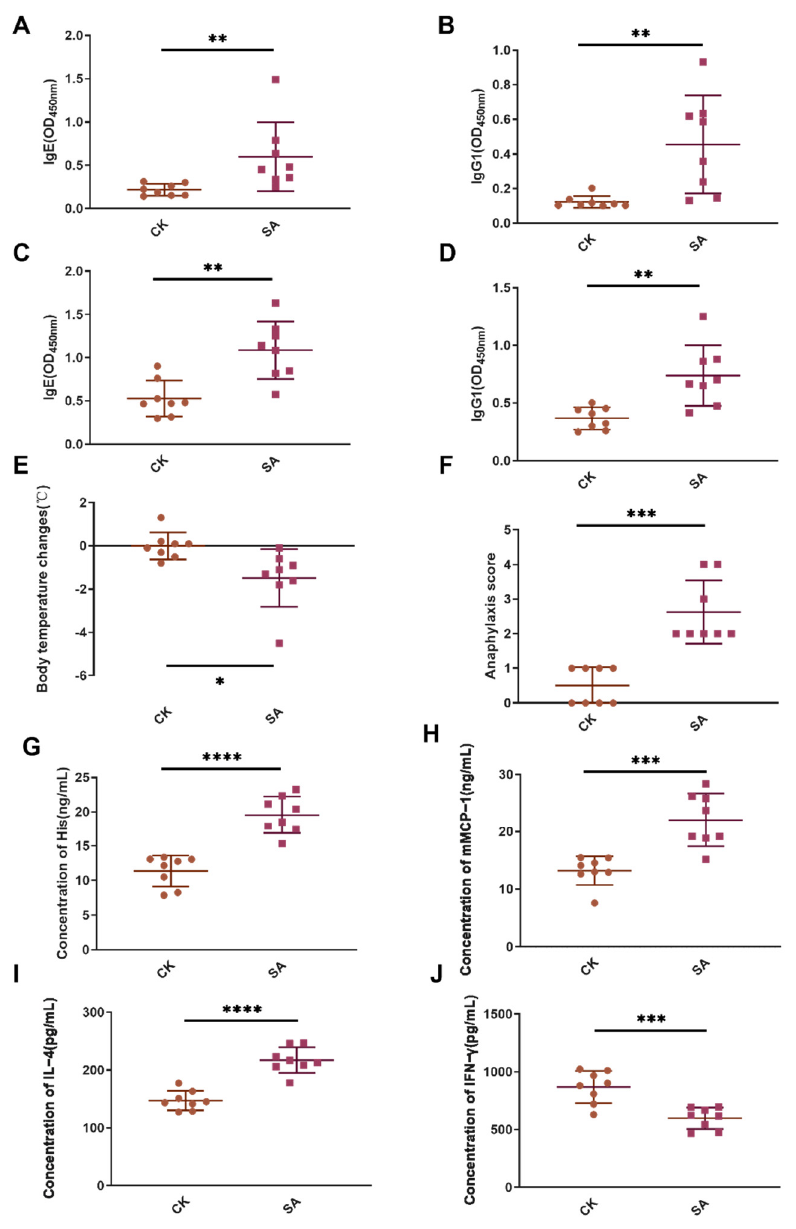
Figure 1. Allergy index analysis of mice in CK and SA groups. ( A , B ) sIgE and sIgG1 levels on day 35; ( C , D ), sIgE and sIgG1 levels on day 42; ( E , F ), body temperature changes and anaphylaxis score after challenge. ( G – J ), histamine, mMCP-1, IL-4, and IFN- γ levels in each group. *, p < 0.05; **, p < 0.01; ***, p < 0.001; ****, p < 0.0001. CK, control group; SA, shrimp allergy group. Square represent mice from SA group; Circle represent mice from CK group. n = 8.